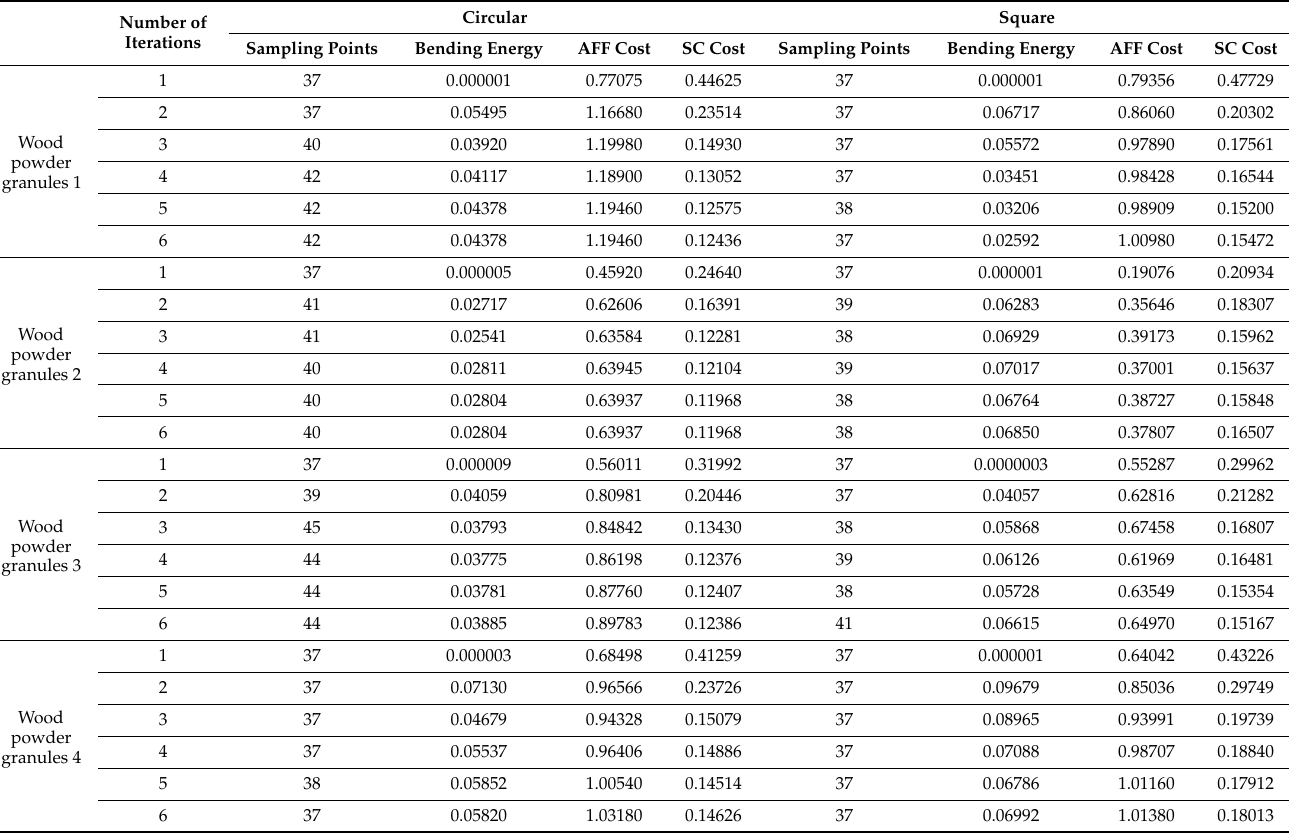
Table 2. Cost of matching wood powder